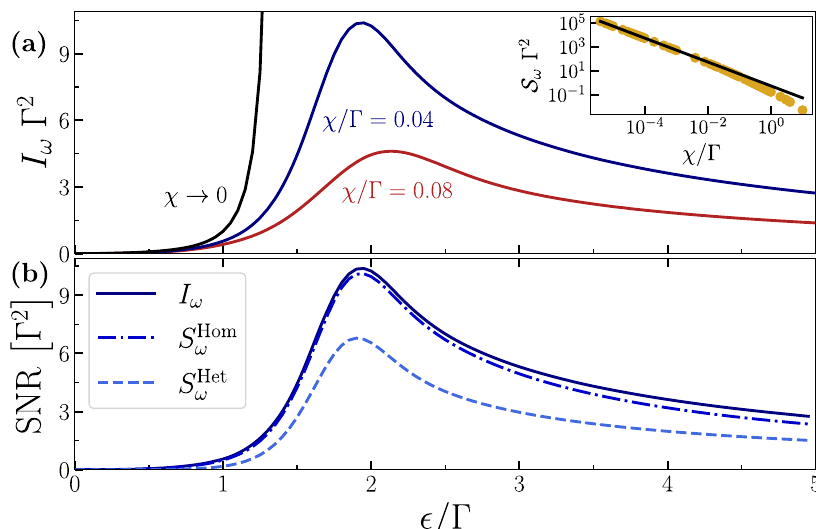
p ffiffiffiffiffiffiffiffiffiffiffiffiffiffiffiffi ω 2 þ Γ 2 . For fi nite values of χ , the QFI has a maximum. p ffiffiffiffiffiffiffi χ (cid:4) 1 Þ , the Heisenberg scaling is reached already